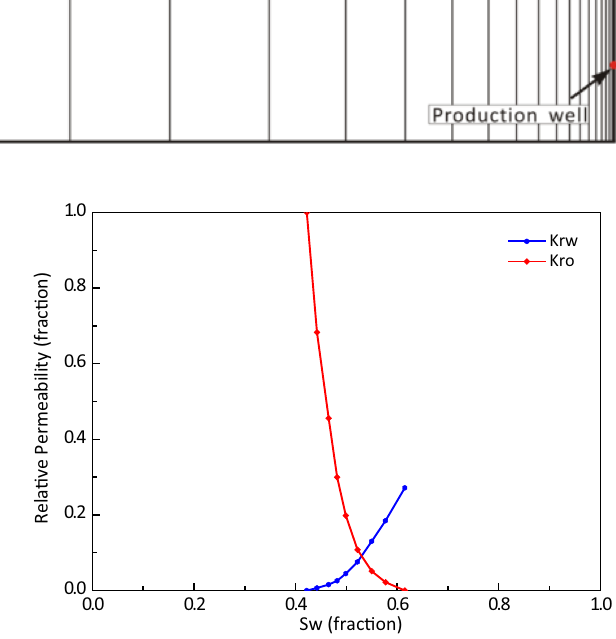
Fig. 10 Top view of reservoir model